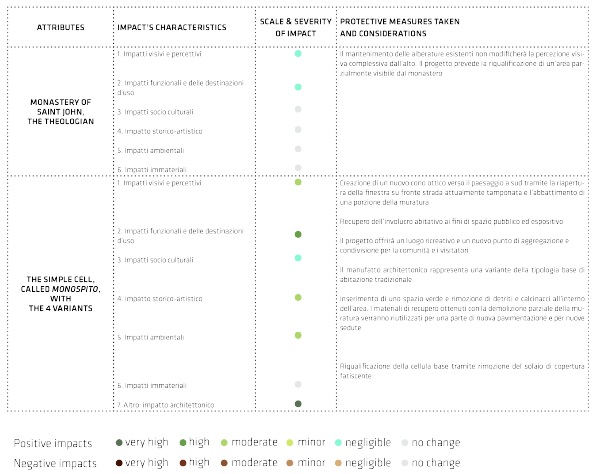
Figure 16. Extract from the scoping report carried out for one of the rehabilitation project for